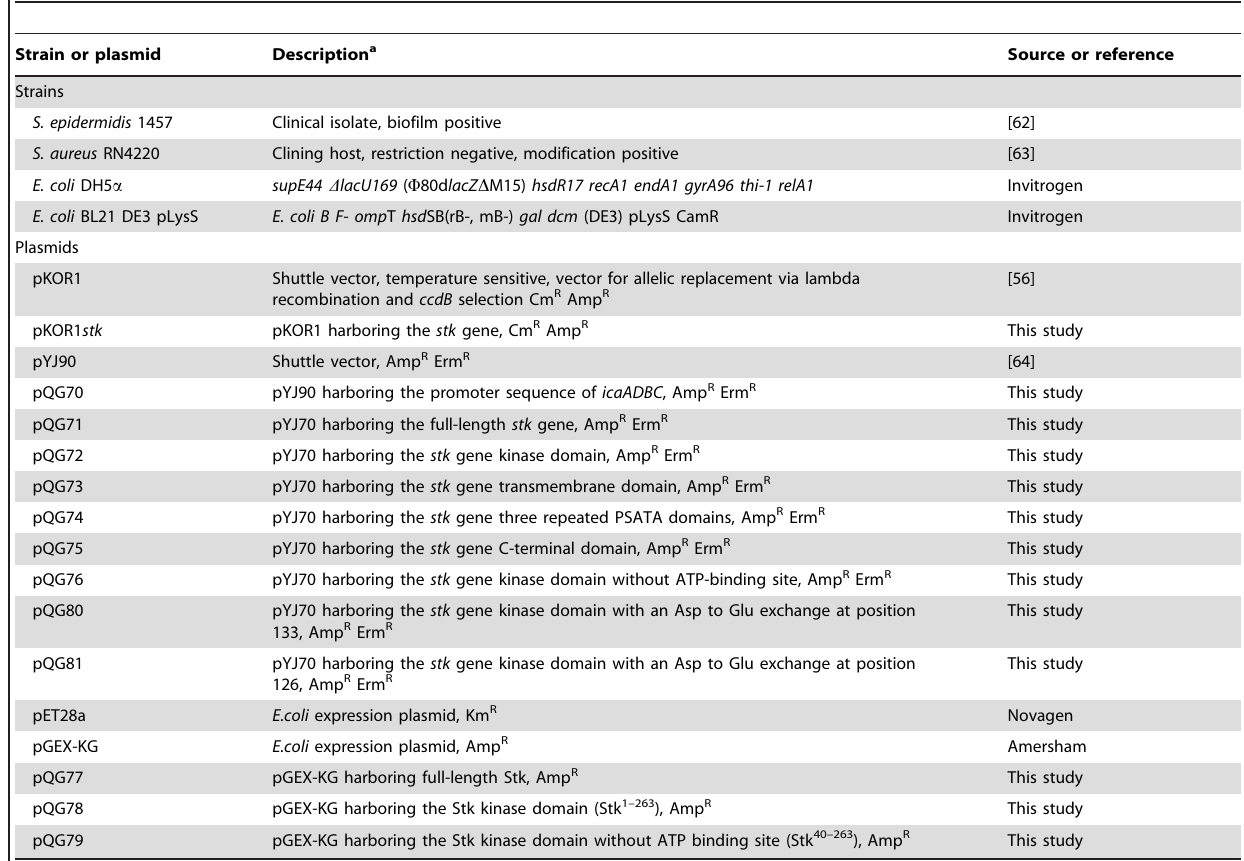
Table 1. Bacterial strains and plasmids used in this